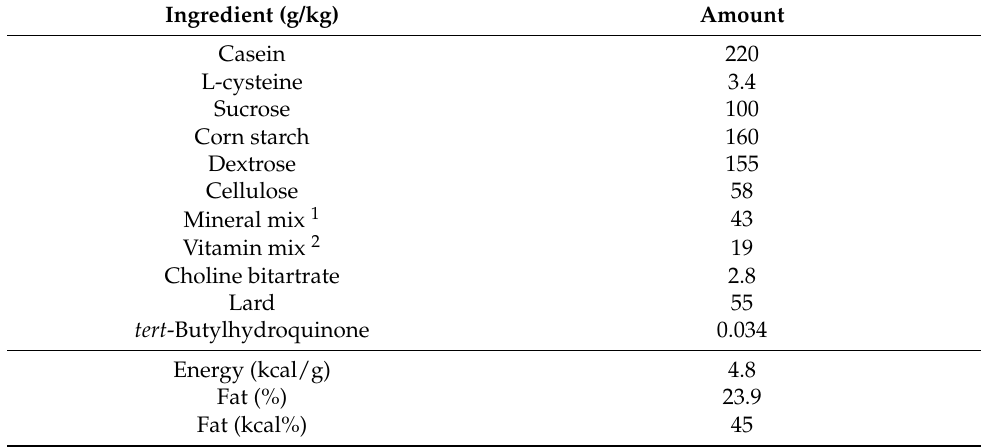
Table 1. Constant ingredients in the three experimental diets.